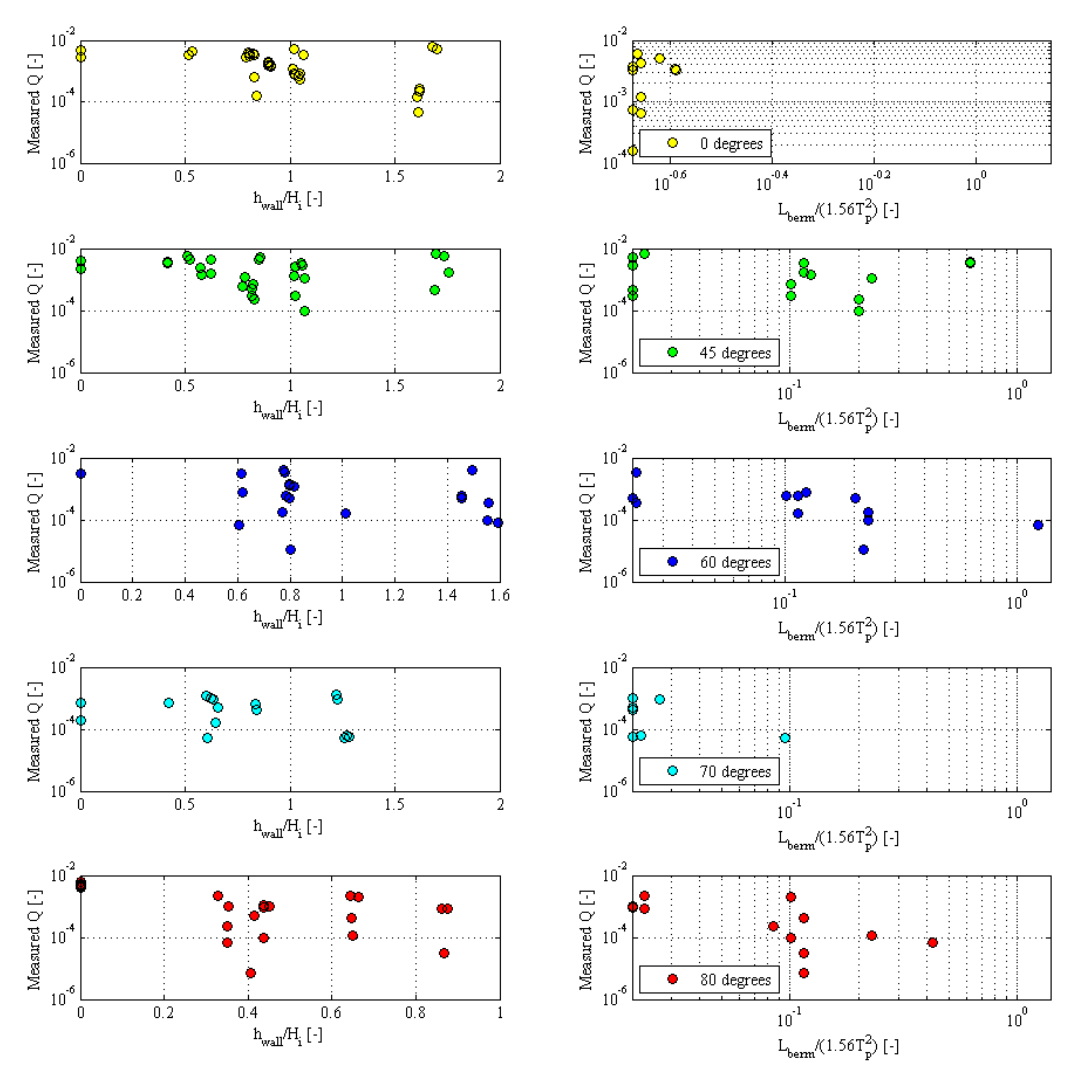
Figure 12. Non-dimensional discharge vs. relative wall height and relative berm length (quay layout).